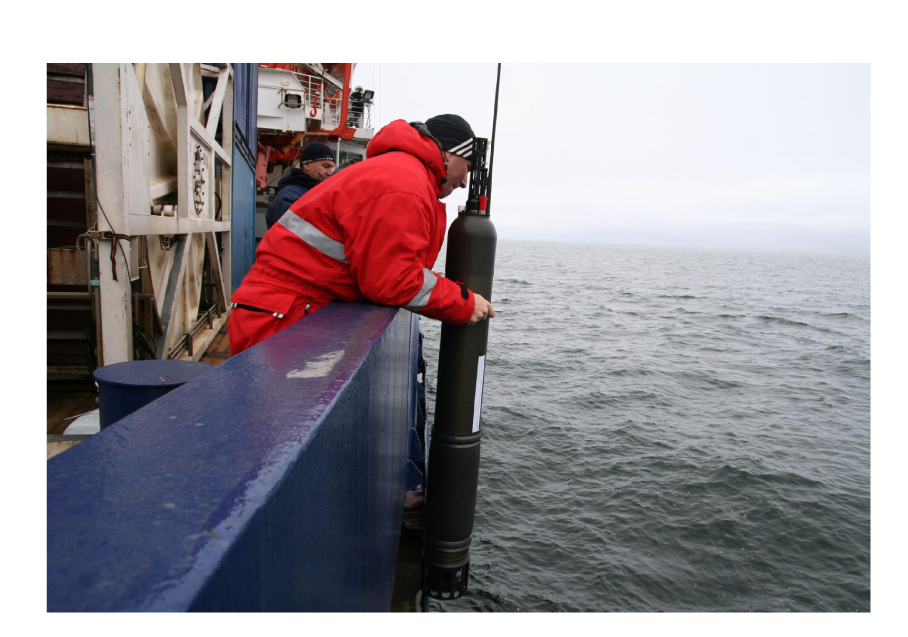
Figure 1: Launching of a NEMO profiler (courtesy of